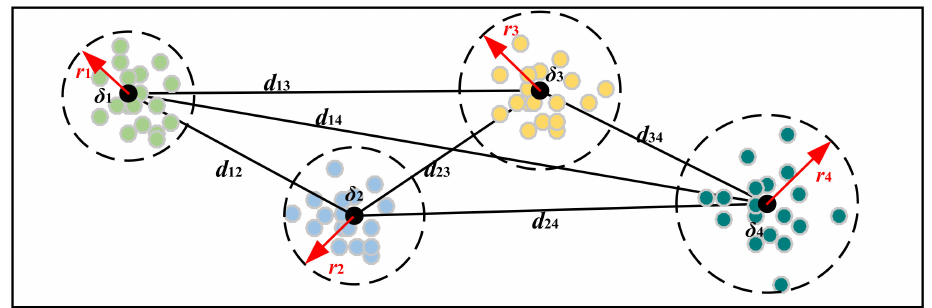
Figure 4. The schematic diagram of class aggregation and class separability